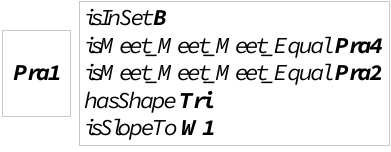
Figure 12. The properties and relations of instance Pra1.